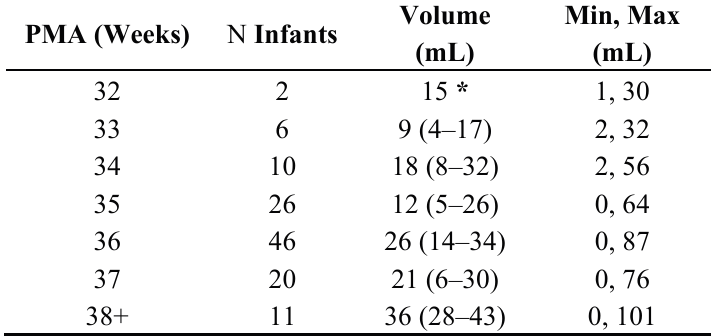
Figure 4 The percentage (%) of breast milk (mLs) taken during a single breastfeed in 10 mL increments. Table 3. Median breast milk intake (mLs) per breastfeed according to post menstrual age